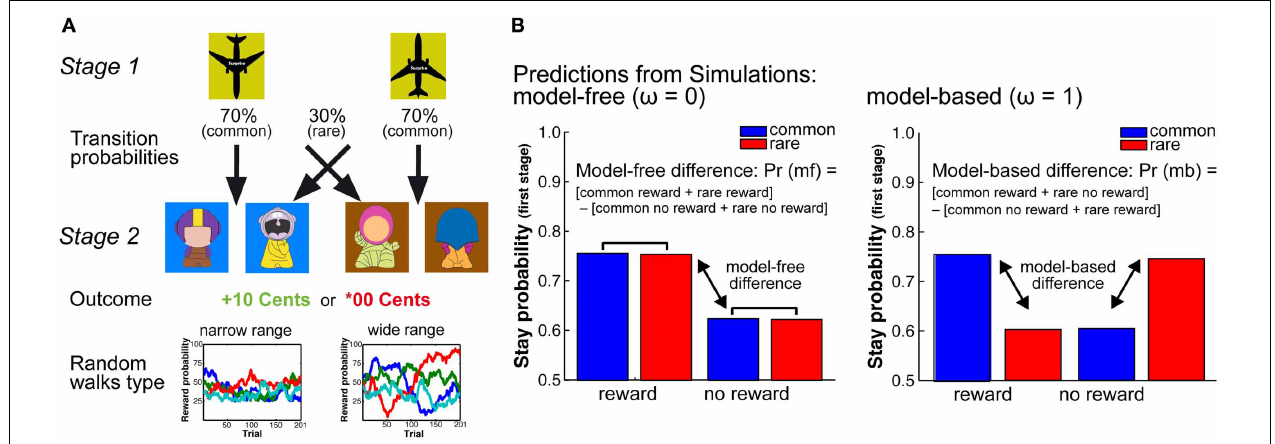
FIGURE 1 | (A) Schematic Figure of the 2-stage Markov decision task. In this task participants have to constantly update reward predictions on the second stage (model-free decision-making) and use these reward predictions to make goal-directed decisions on the first stage of the task. To support model-free learning in the two age groups we manipulated the random walks that determine the probability of getting a reward at the second stage. We applied twodifferentprobabilityranges,onewithanarrowrangeofrewardprobabilities (25–75% reward probability) and one with a wide range of reward probabilities